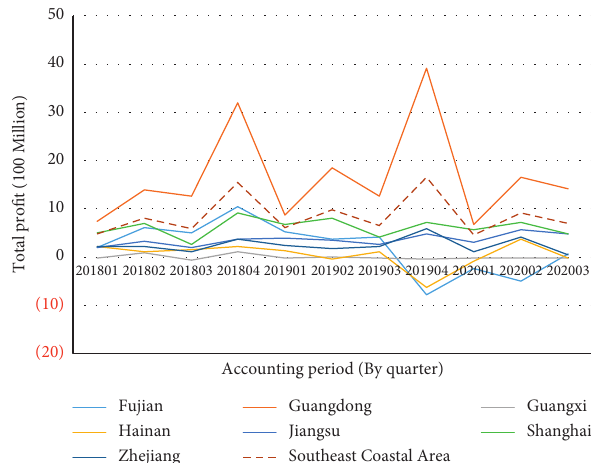
Figure 7: Changes in the total profits of sample